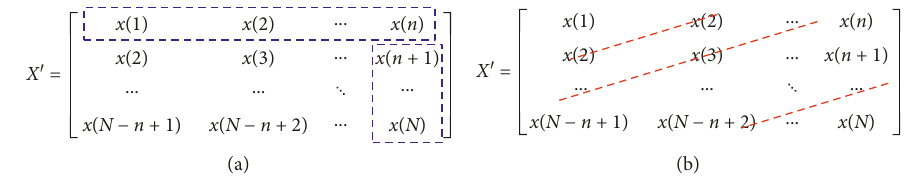
Figure 1: Two approaches to convert Hankel matrix signal to time series